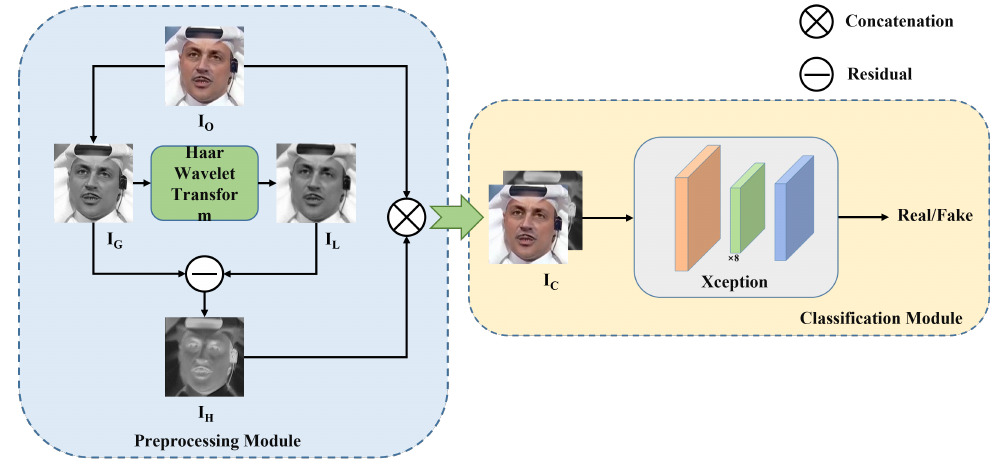
Figure 2. The framework of the